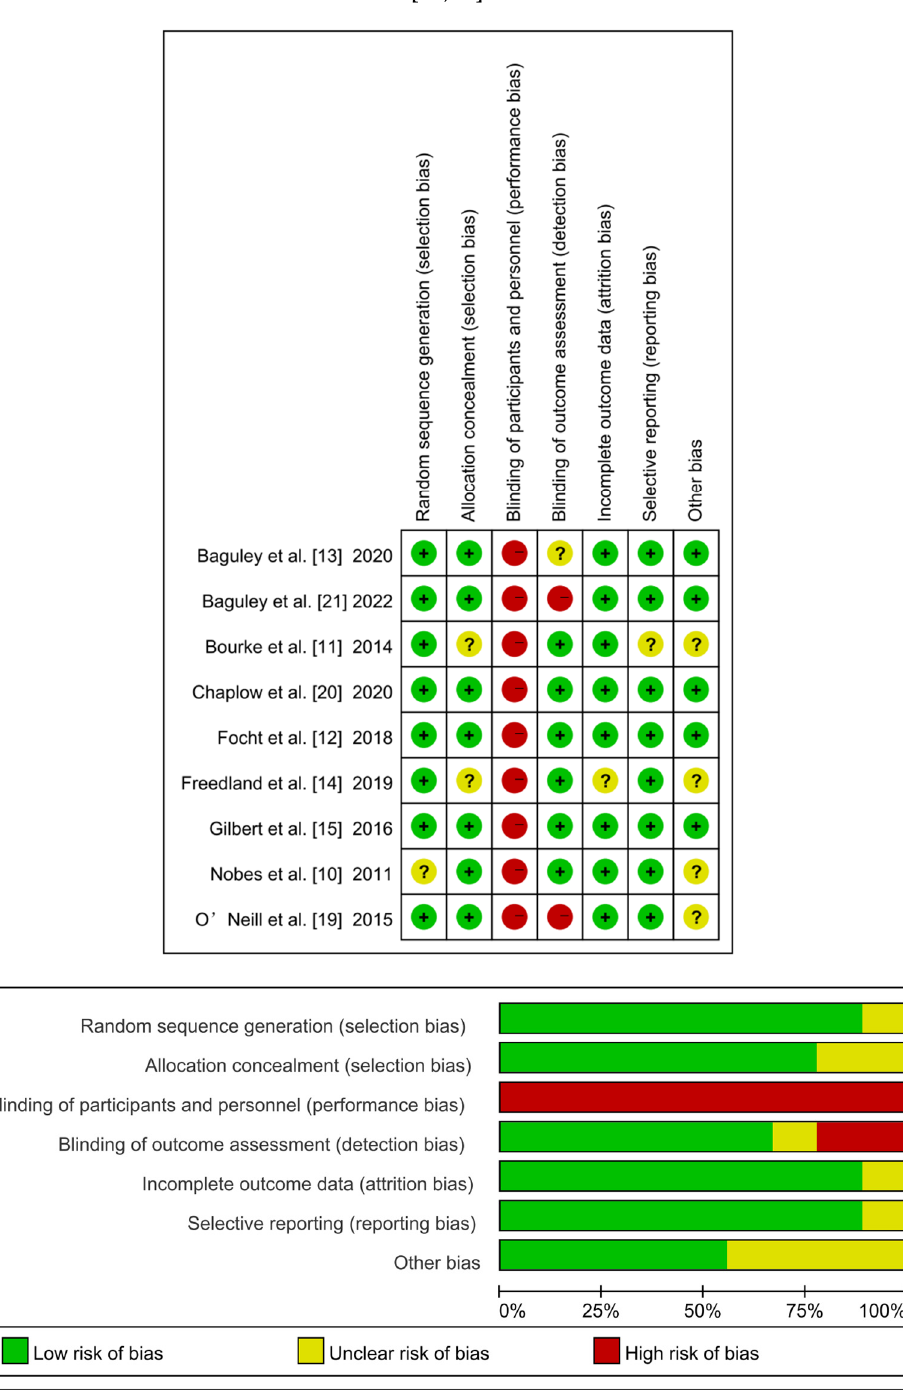
Figure 2. Risk of bias assessment results for included studies. “+”: low risk of bias; “?”: unclear risk of bias; “ − ”: high risk of bias.